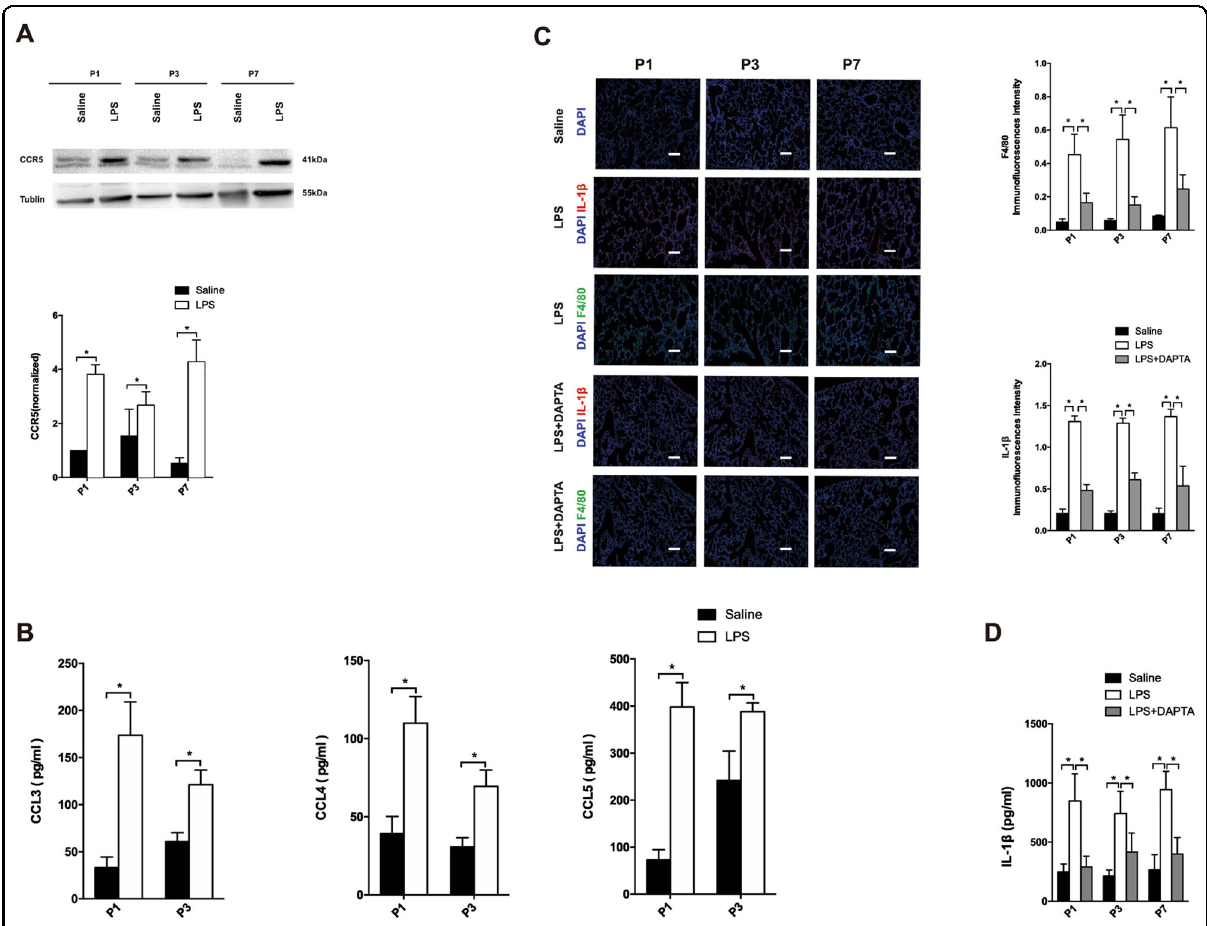
Fig. 3 CCR5 inhibition reduced the numbers of macrophages in the lungs and suppressed IL-1 β overproduction in the rat model of BPD. A Representative immunoblot probed for CCR5 in whole lung lysates of P1, P3, and P7 rats. Data are expressed as mean ± SD ( n = 6), * p < 0.05. B CCL3, CCL4, and CCL5 levels in rat lung tissues. Data are expressed as mean ± SD ( n = 8), * p < 0.05. C Representative images of lung tissues immunostained for F4/80 and IL-1 β . Scale bar: 50 μ m. Quantitation of F4/80 and IL-1 β fl uorescence intensity. Data are expressed as mean ± SD ( n = 6), * p < 0.05. D IL-1 β protein level in rat lung tissues. Data are expressed as mean ± SD ( n = 8), * p <